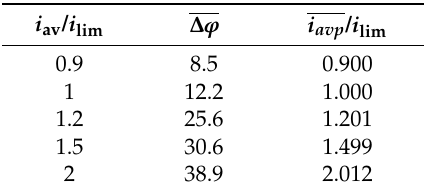
Table 1. The potential drop (PD) and average current density in the quasi-stationary state in the galvanostatic and potentiostatic